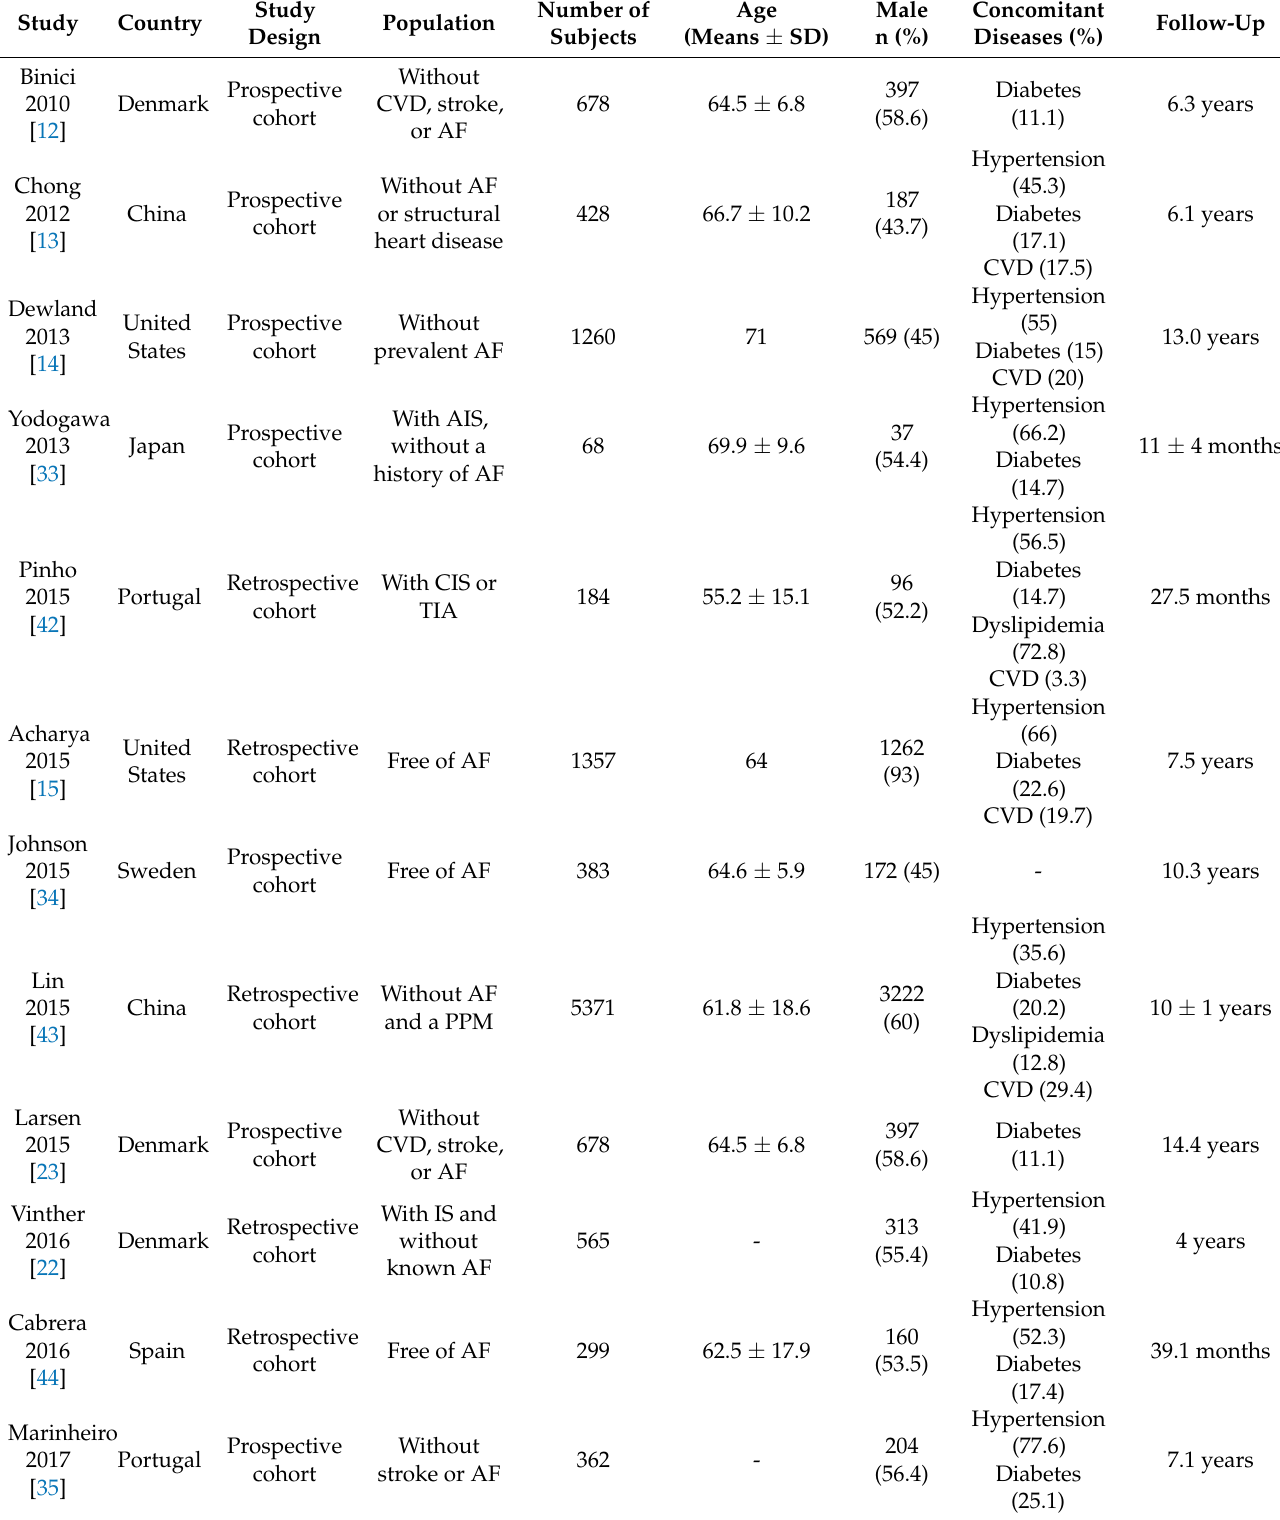
Table 1. Characteristics of the included